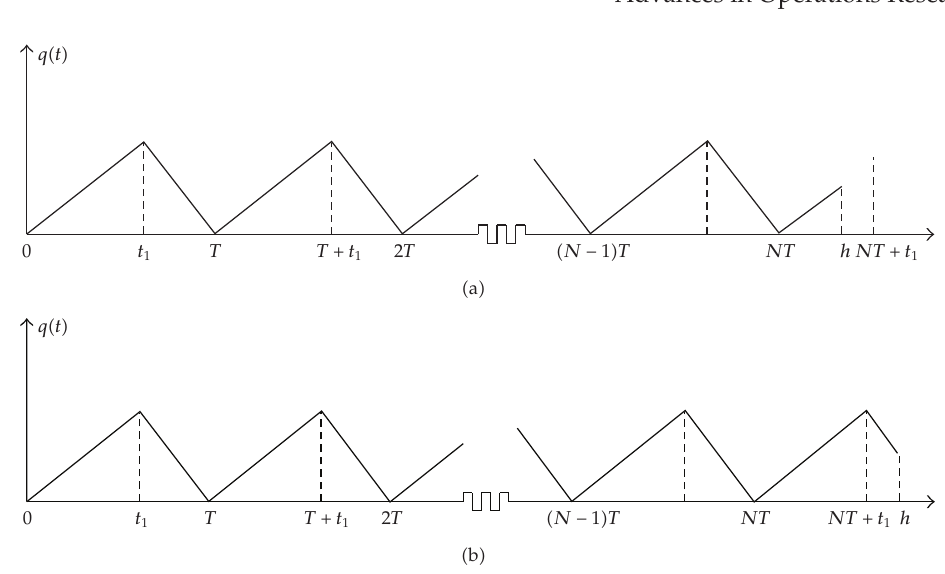
Figure 1: (cid:4) a (cid:5) . Inventory level when NT < h < NT (cid:8) t 1 . (cid:4) b (cid:5) Inventory level when NT (cid:8) t 1 < h < (cid:4) N (cid:8) 1 (cid:5) T